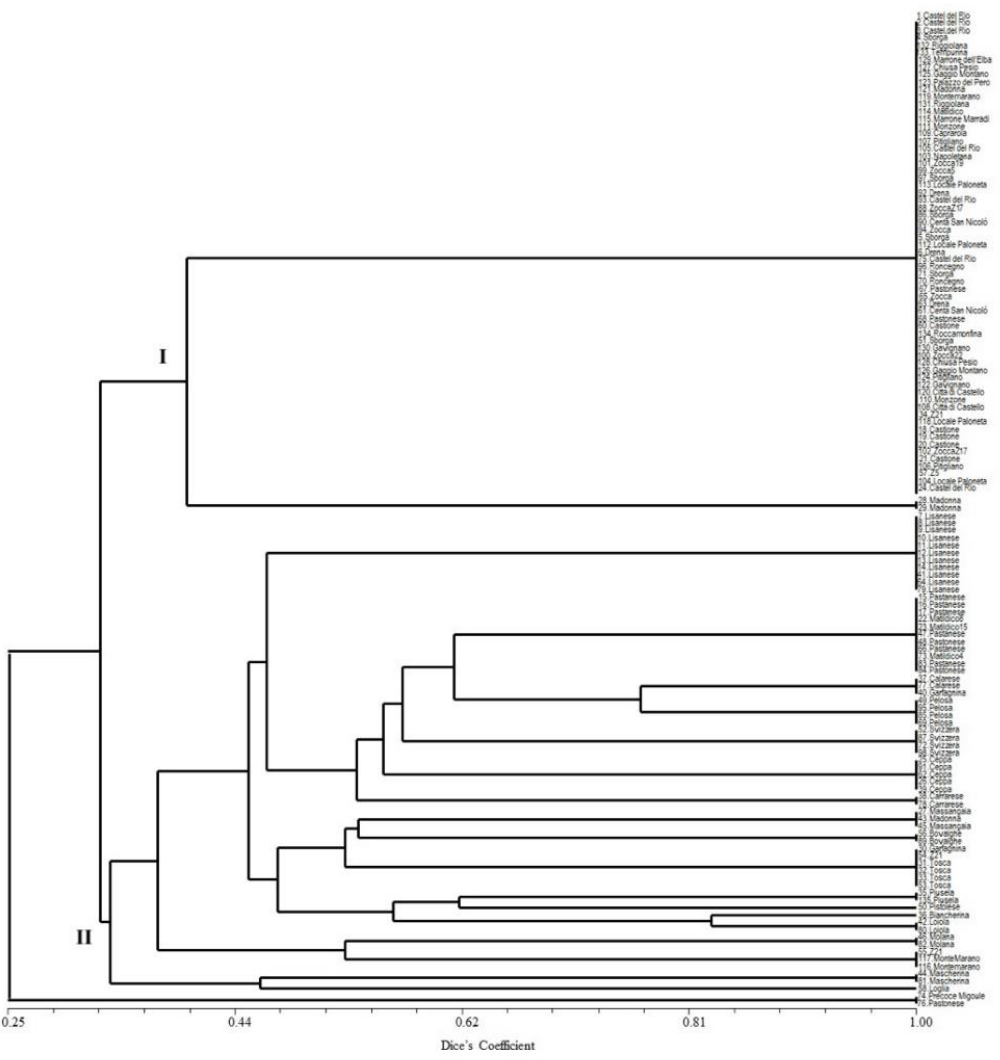
Figure 1. Dendrogram based on 16 SSRs using DICE coefficient demonstrating genetic characterization and relationship of 134 chestnut accessions from the Tuscan-Emilian Apennines, divided in two